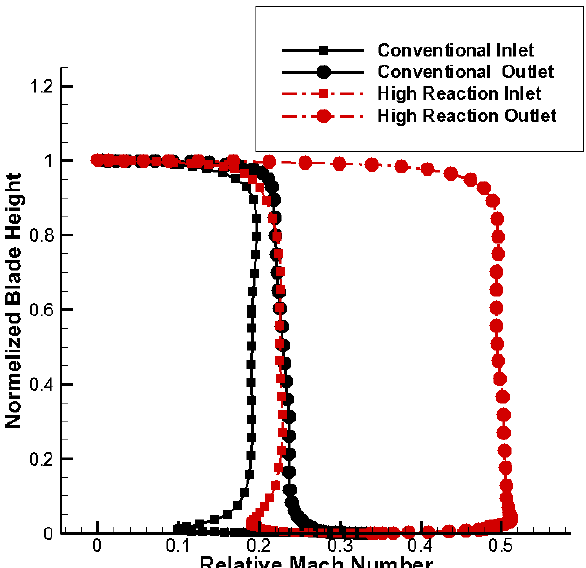
Figure 14. Profiles of the relative Mach number of two different designed tip turbines.